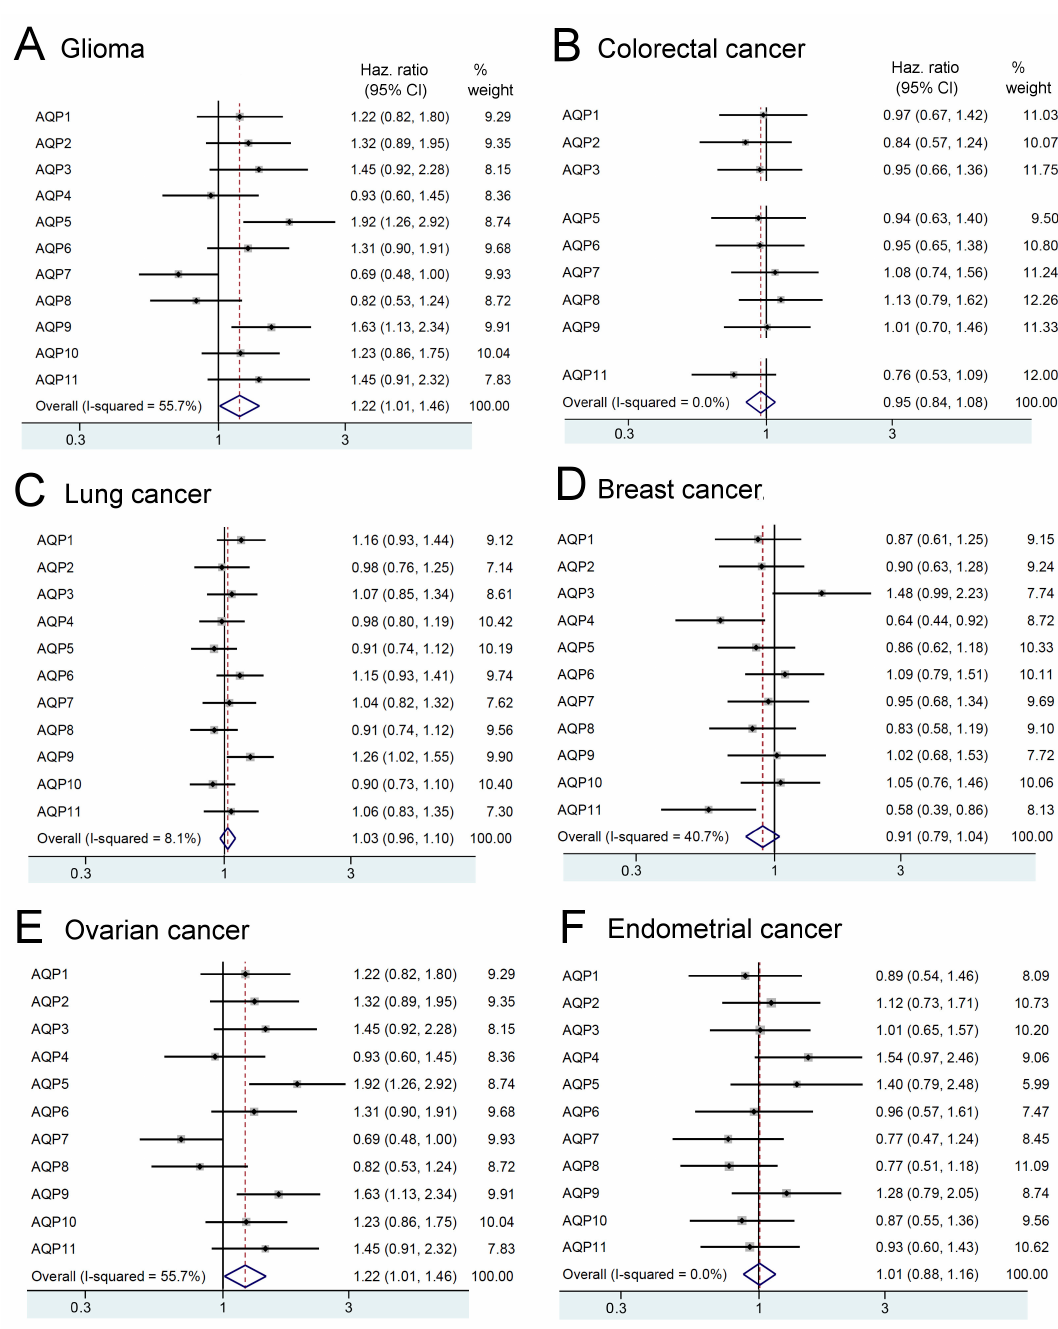
Figure 4. Increases and decreases in the risk of death for cancer patients show patterns associated with the upregulation of transcript levels for different classes of AQPs, depending on cancer type. Forest plots depict associations between survival time and median RNA expression compiled for multiple samples (patient data from the Human Protein Atlas) for six types of cancers ( A – F ). Hazard ratios estimate the magnitude of the effect, calculated using an interactive algorithm on the Atlas site that divides populations into high and low expression groups by median FPKM values. The vertical line indicates no effect (odds ratio 1.0); horizontal lines indicate 95% confidence interval (CI); the percent weight reflects the power of the analysis (increased by higher n values and tighter confidence intervals).